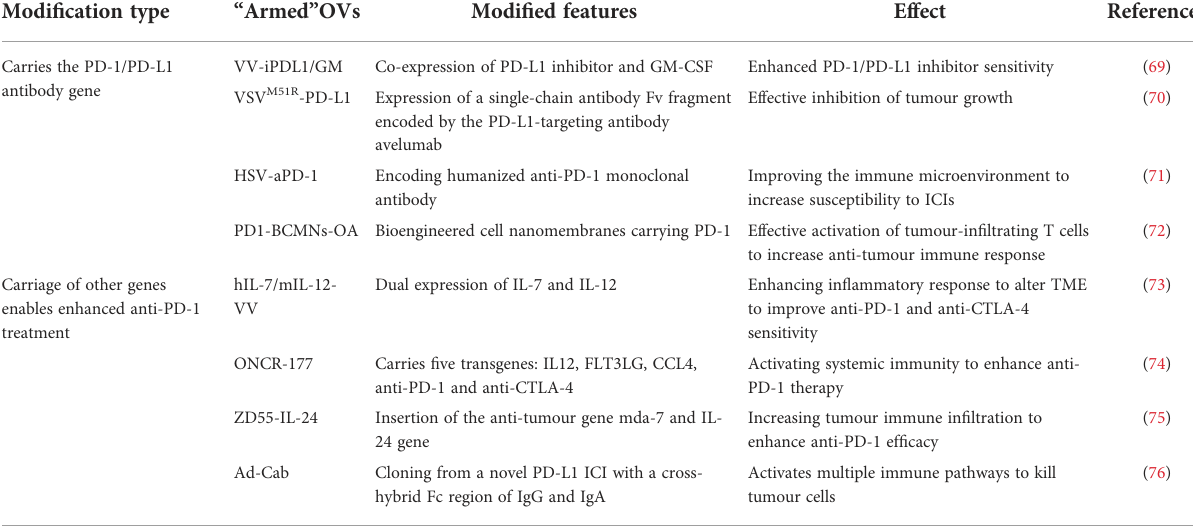
TABLE 2 Modi fi cation and effects of “ armed ” oncolytic